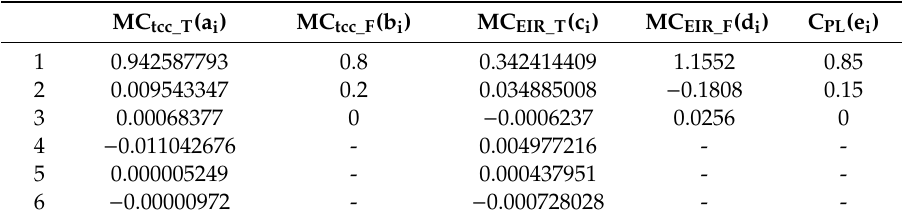
Table 3. Coe ffi cients of cooling capacity and EIR modifier